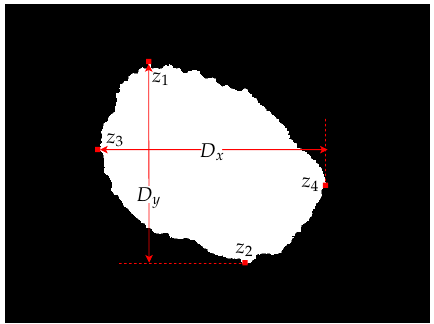
Figure 13. The four extremity pixels and the distances between